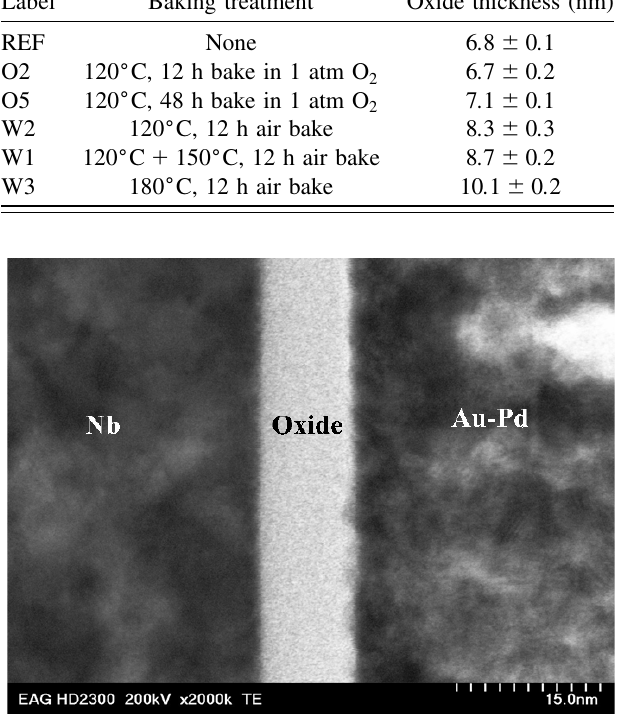
FIG. 11. TEM cross-section micrograph of the sample W3 baked in air at 180 (cid:3) C for 12 h, showing a distinct oxide layer on the Nb